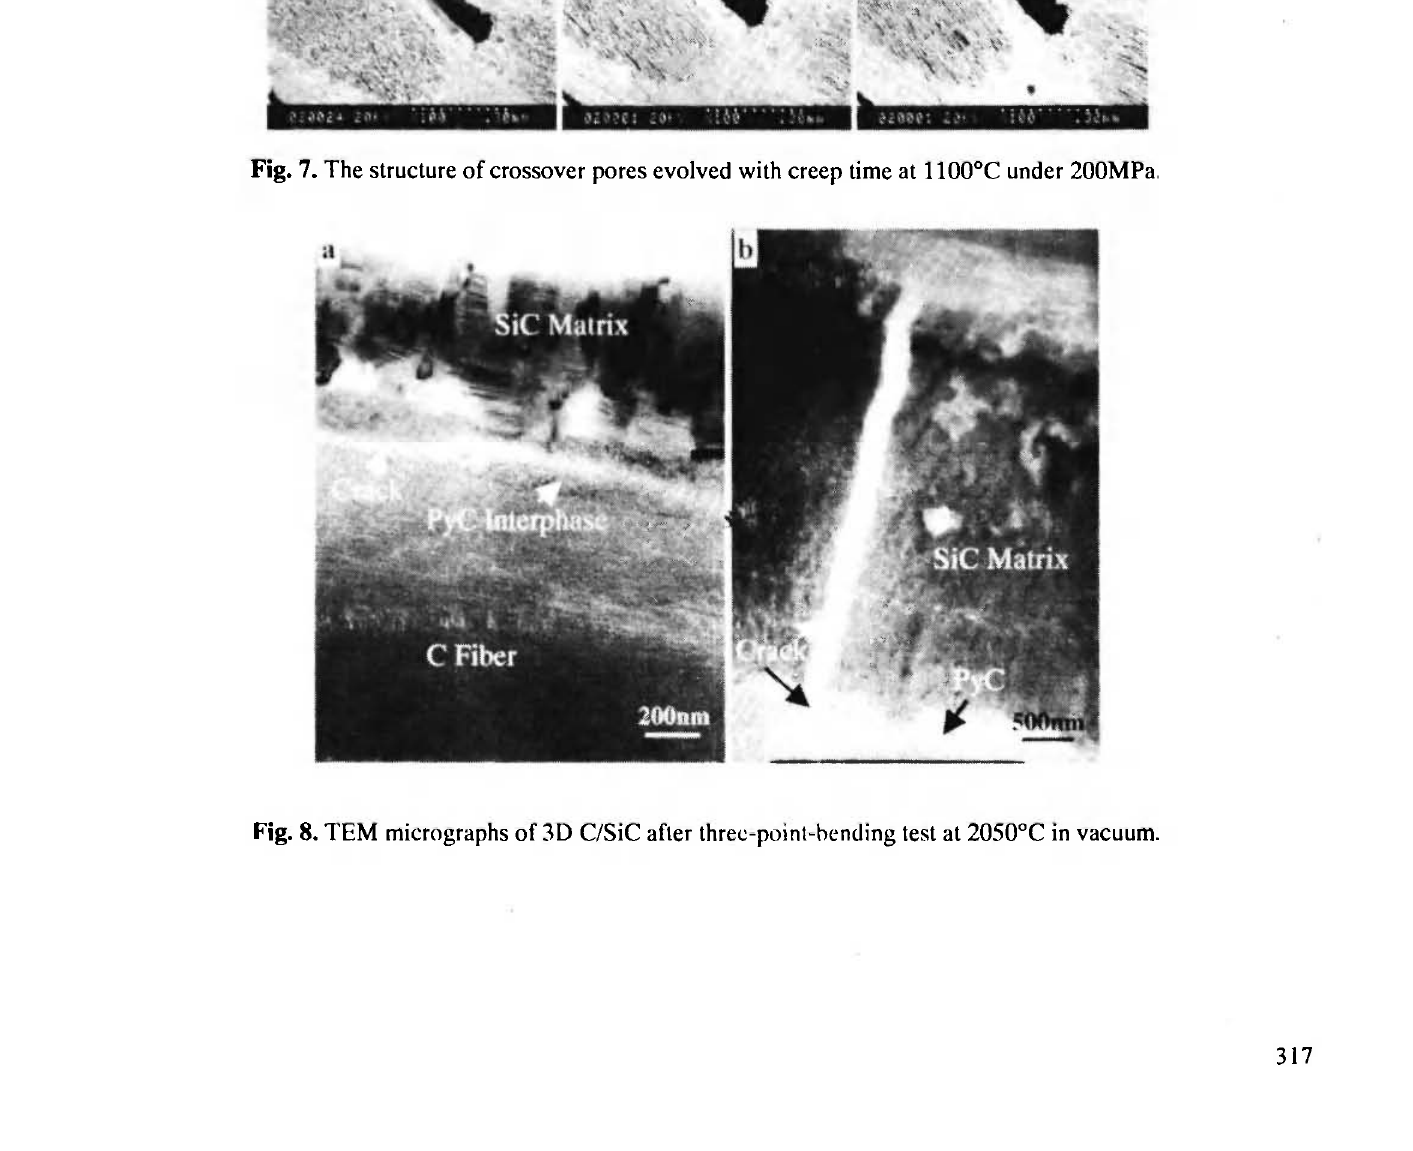
Fig. 7. The structure of crossover pores evolved with creep time at 1100°C under 200MPa,